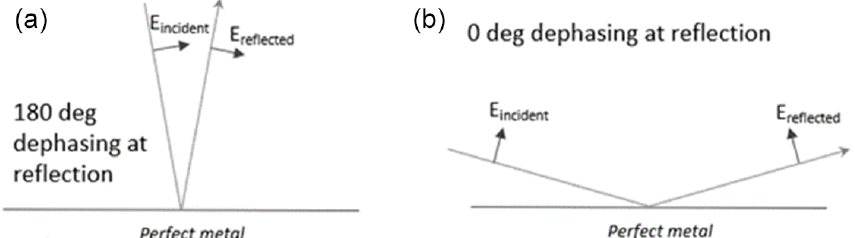
Figure 5. Definition of phase reflectance in P polarization. (a) Situation close to normal incidence. The P-polarized electric fields before and after reflection are defined according to McLeod (2017) and are pointing in the same direction. For an ideal metal with infinite conductivity the phase shift at reflection is 180 ◦ . (b) Situation close to grazing incidence. We adopt the opposite definition to McLeod (2017), with electric fields pointing in opposite direction if the incidence angle was reduced to zero. At grazing incidence it means the electric fields are pointing towards the same direction. For an ideal metal the phase shift at reflection is now 0 ◦ due to the different